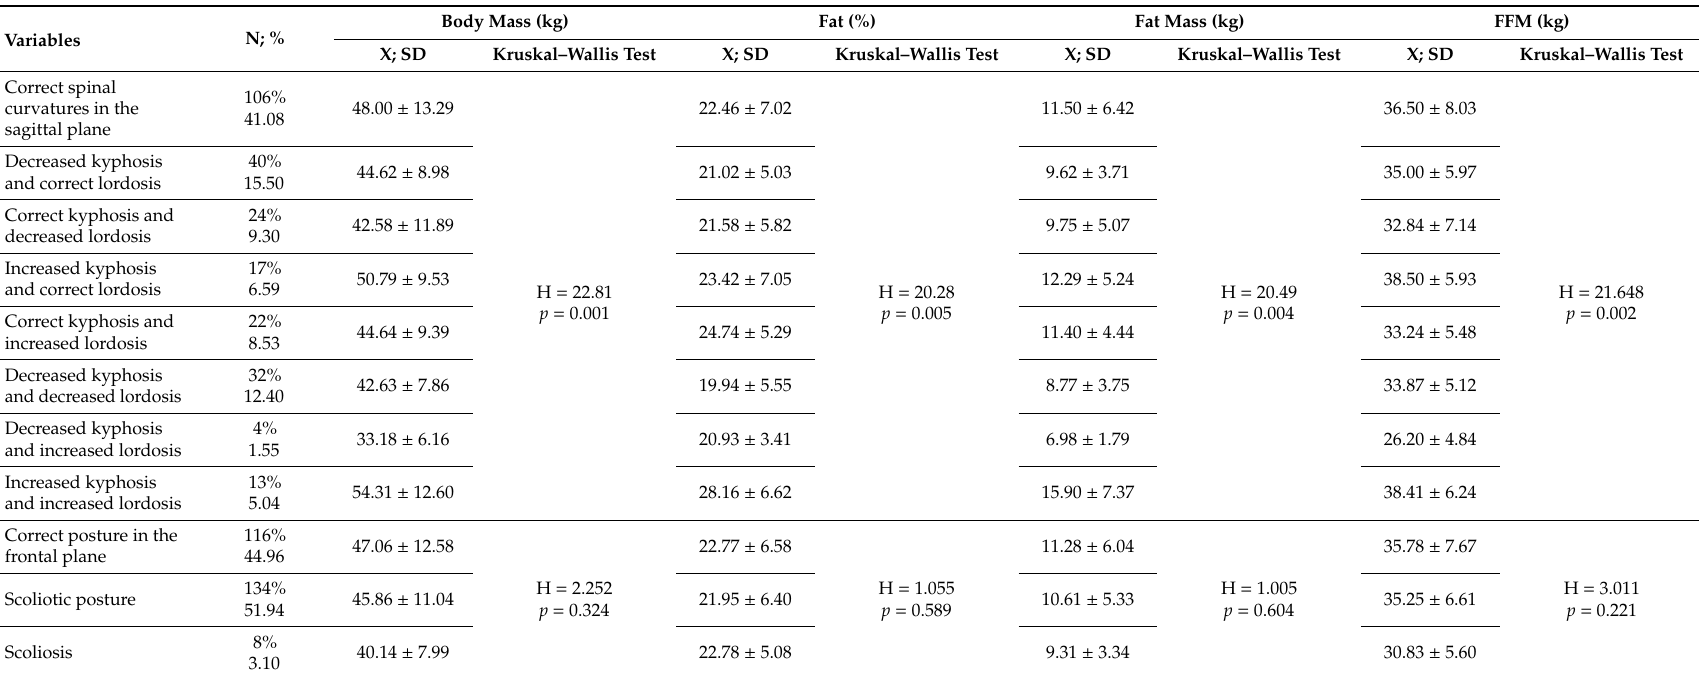
Table 2. Body posture defects according to body